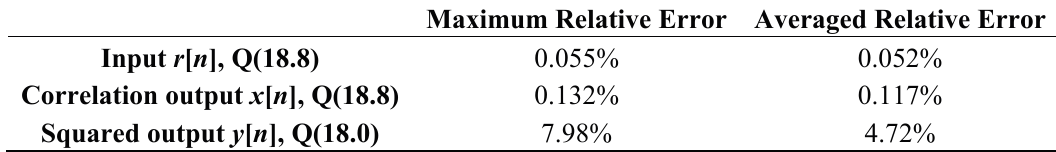
Table 3. Relative quantization errors for the main signals in the proposed